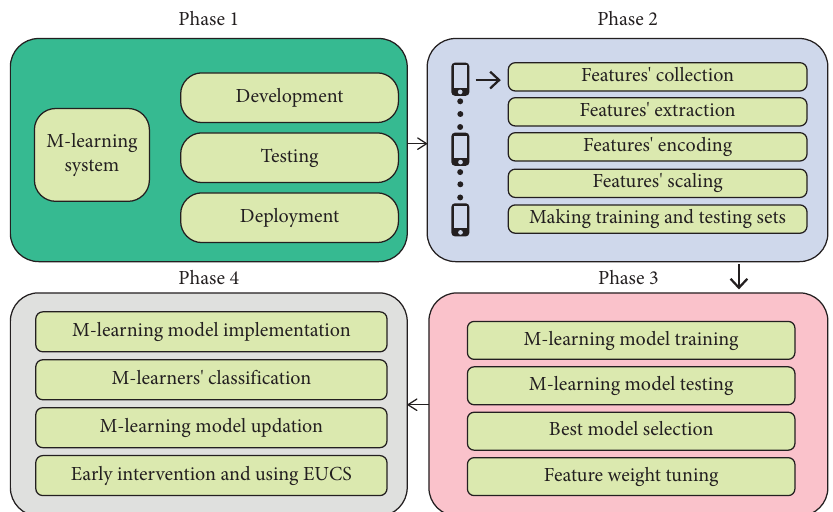
Figure 1: Workflow steps during M-learning model development and